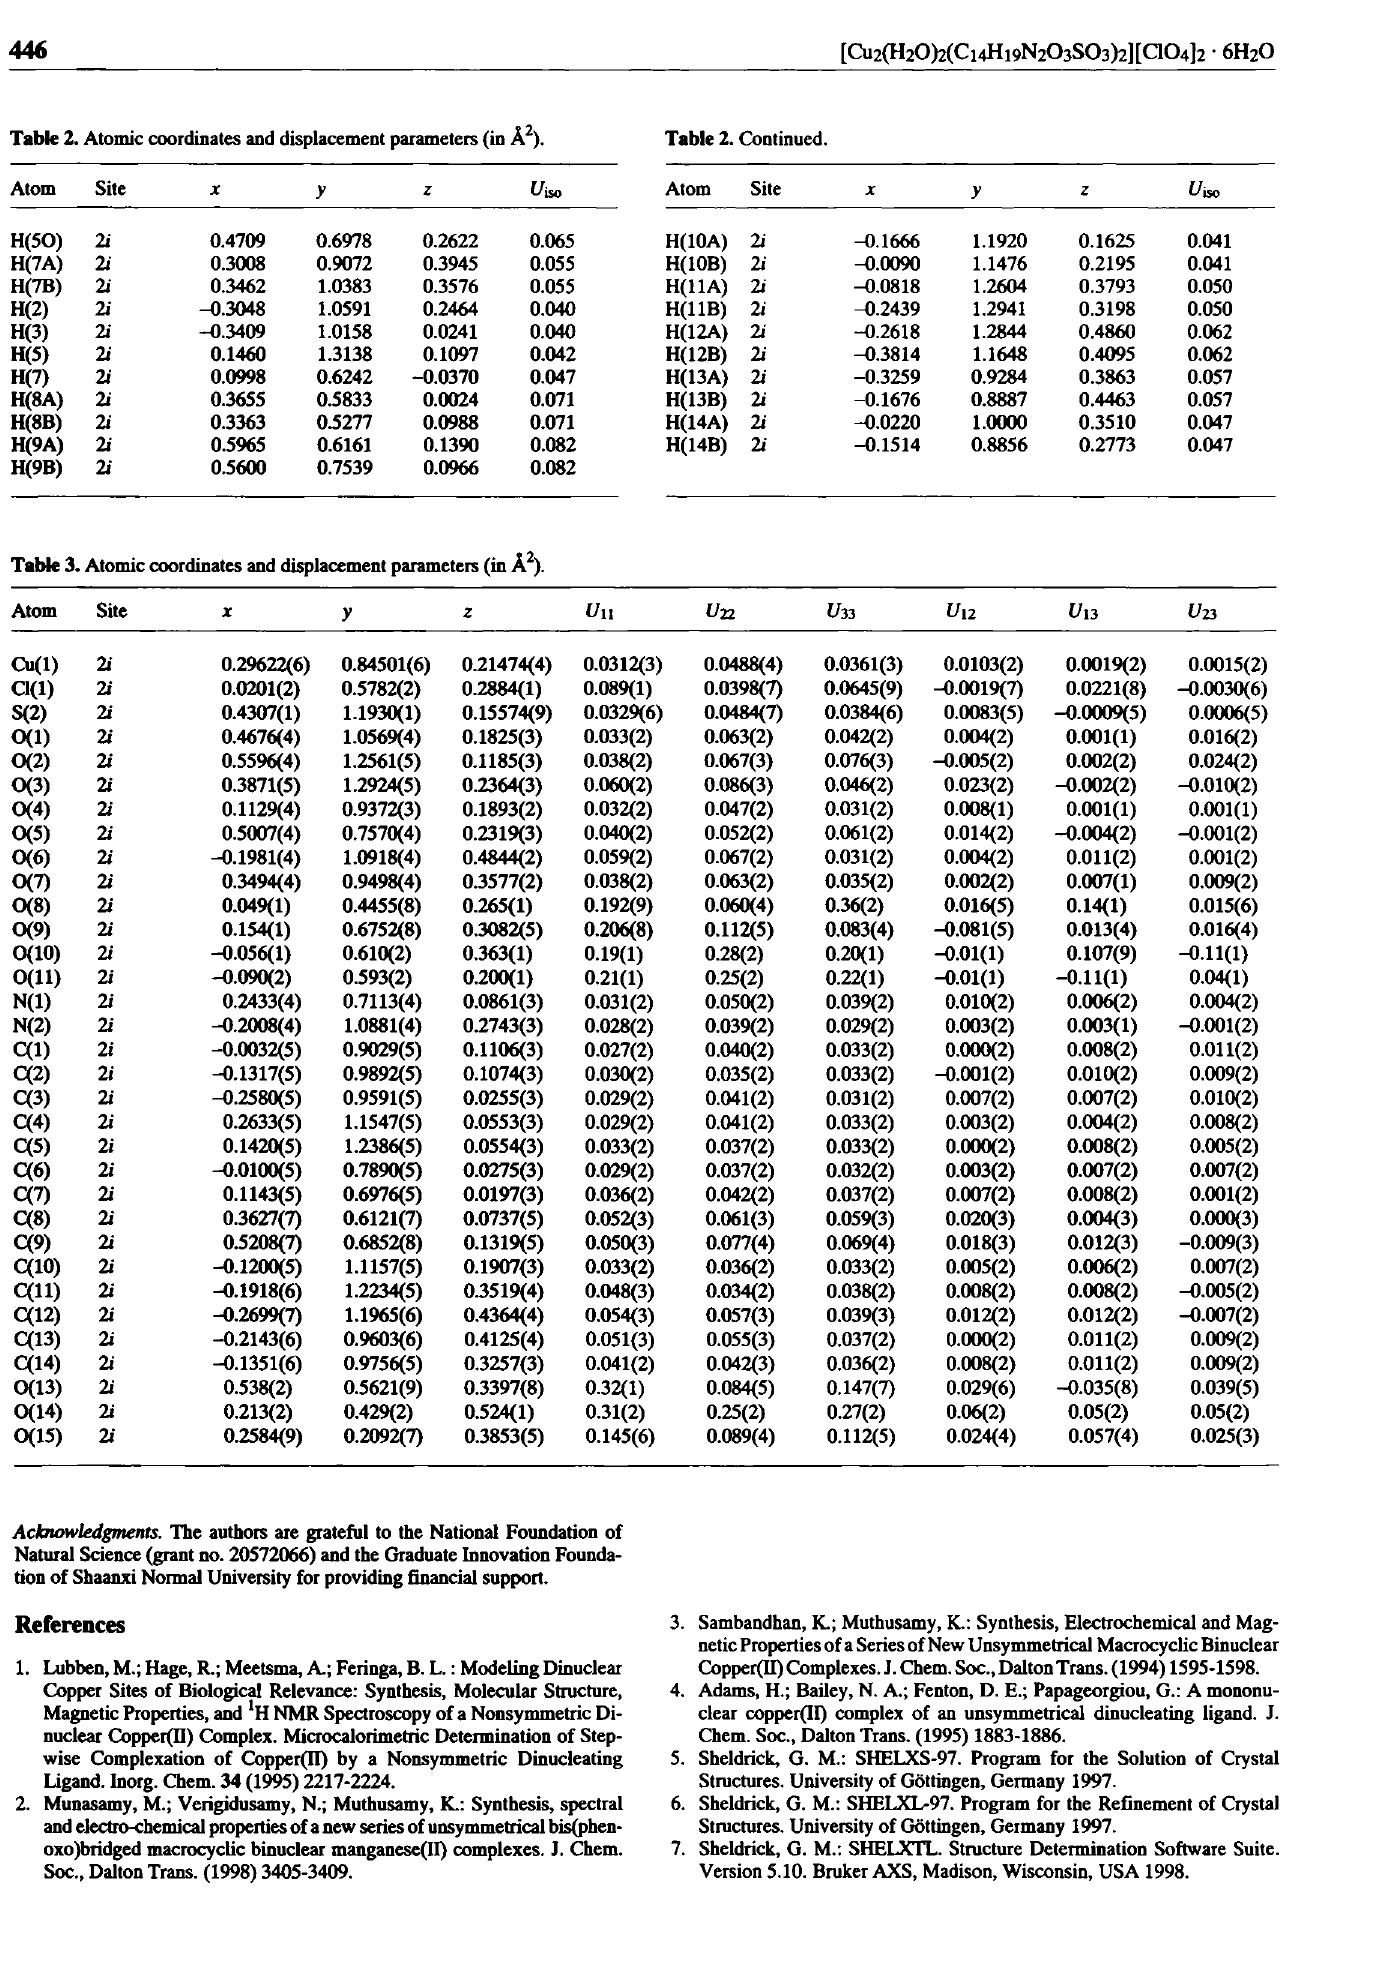
Table 2. Atomic coordinates and displacement parameters (in Ä 2 ). Table 2. Continued.